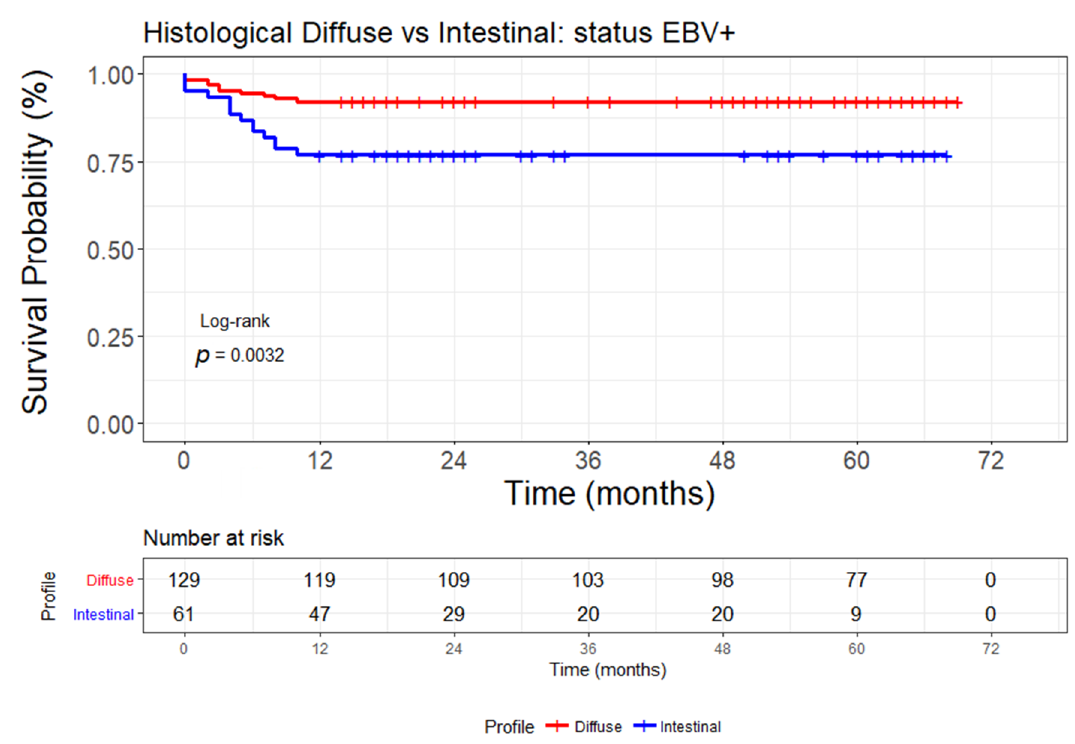
Figure 6. Overall survival (in months) analysis by Kaplan–Meier curves of gastric cancer patients with diffuse and intestinal histological types only in patients with EBV-positive (EBV+) status. Patients with diffuse GC have longer survival than patients with intestinal GC. The log-rank test with p < 0.05 was used to differentiate the groups.